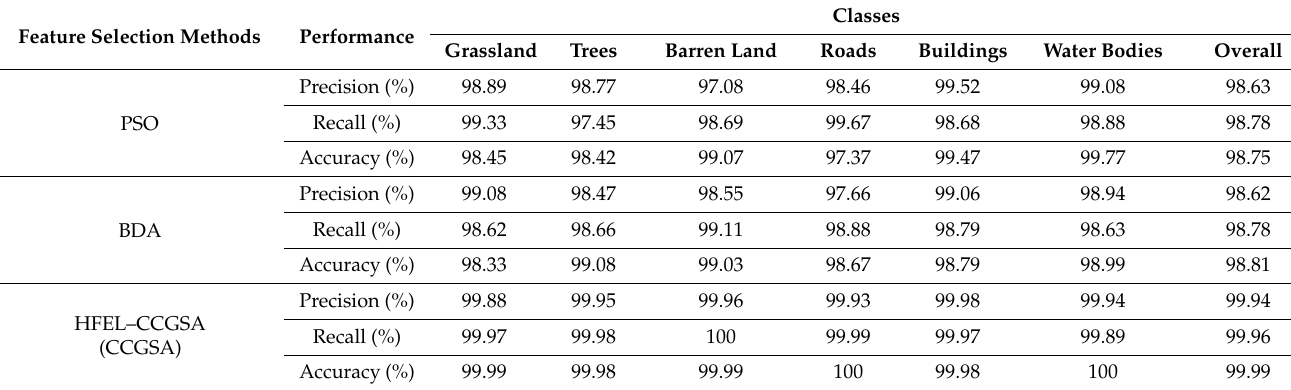
Table 6. Performance analysis for different feature selection methods and HFEL–CCGSA on SAT-6 dataset. Feature Selection Methods